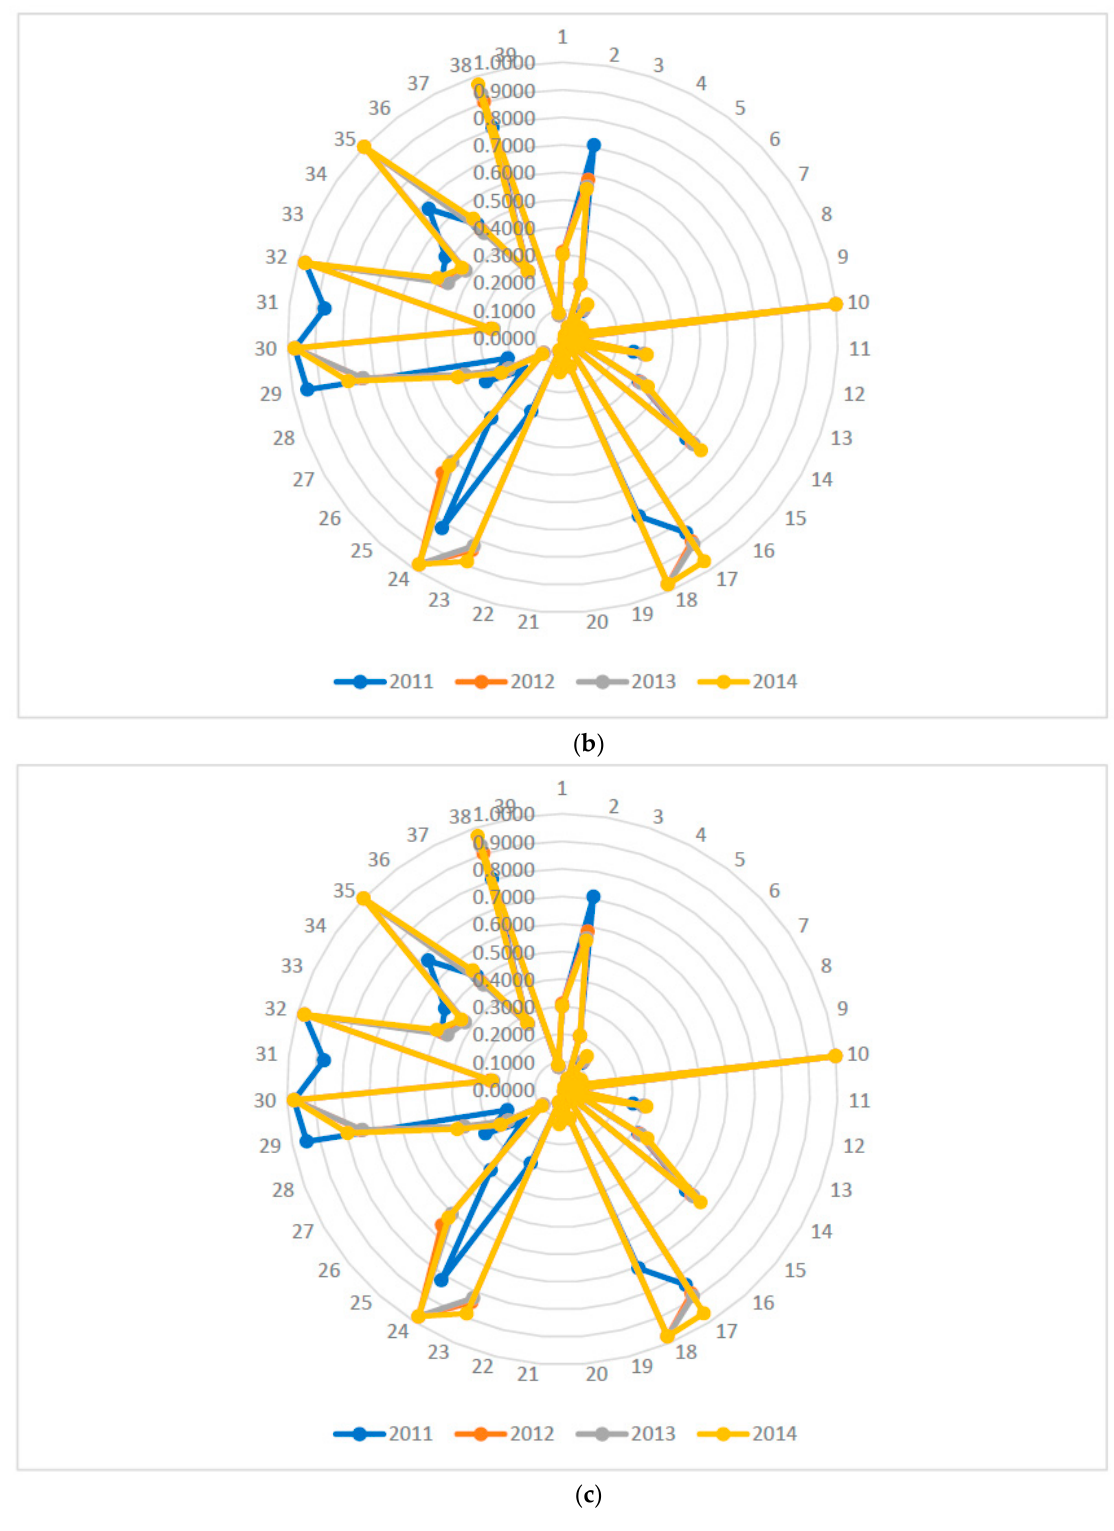
Figure 2. TFE of wastewater control in different industries of China, 2003–2014: ( a ) TFE of wastewater control in different industries of China, 2003–2006; ( b ) TFE of wastewater control in different industries of China, 2007–2010 and ( c ) TFE of wastewater control in different industries of China, 2011–2014 (the serial numbers from 1 to 39 in Figure 2 correspond to the industrial sectors in Table S1).